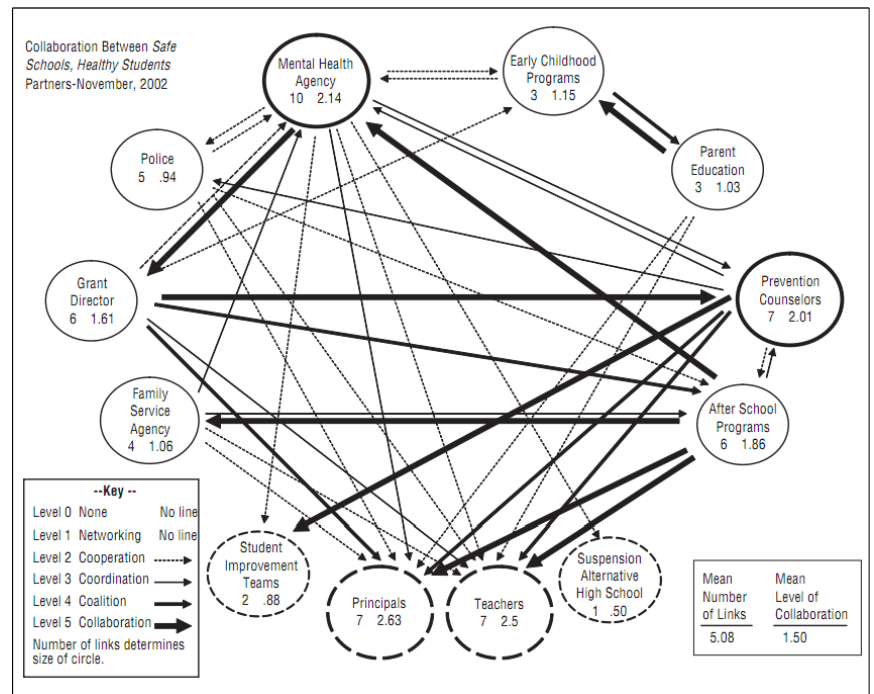
Figure 1. Example of Frey, Lohmeier, Lee, and Tollefson’s Collaboration